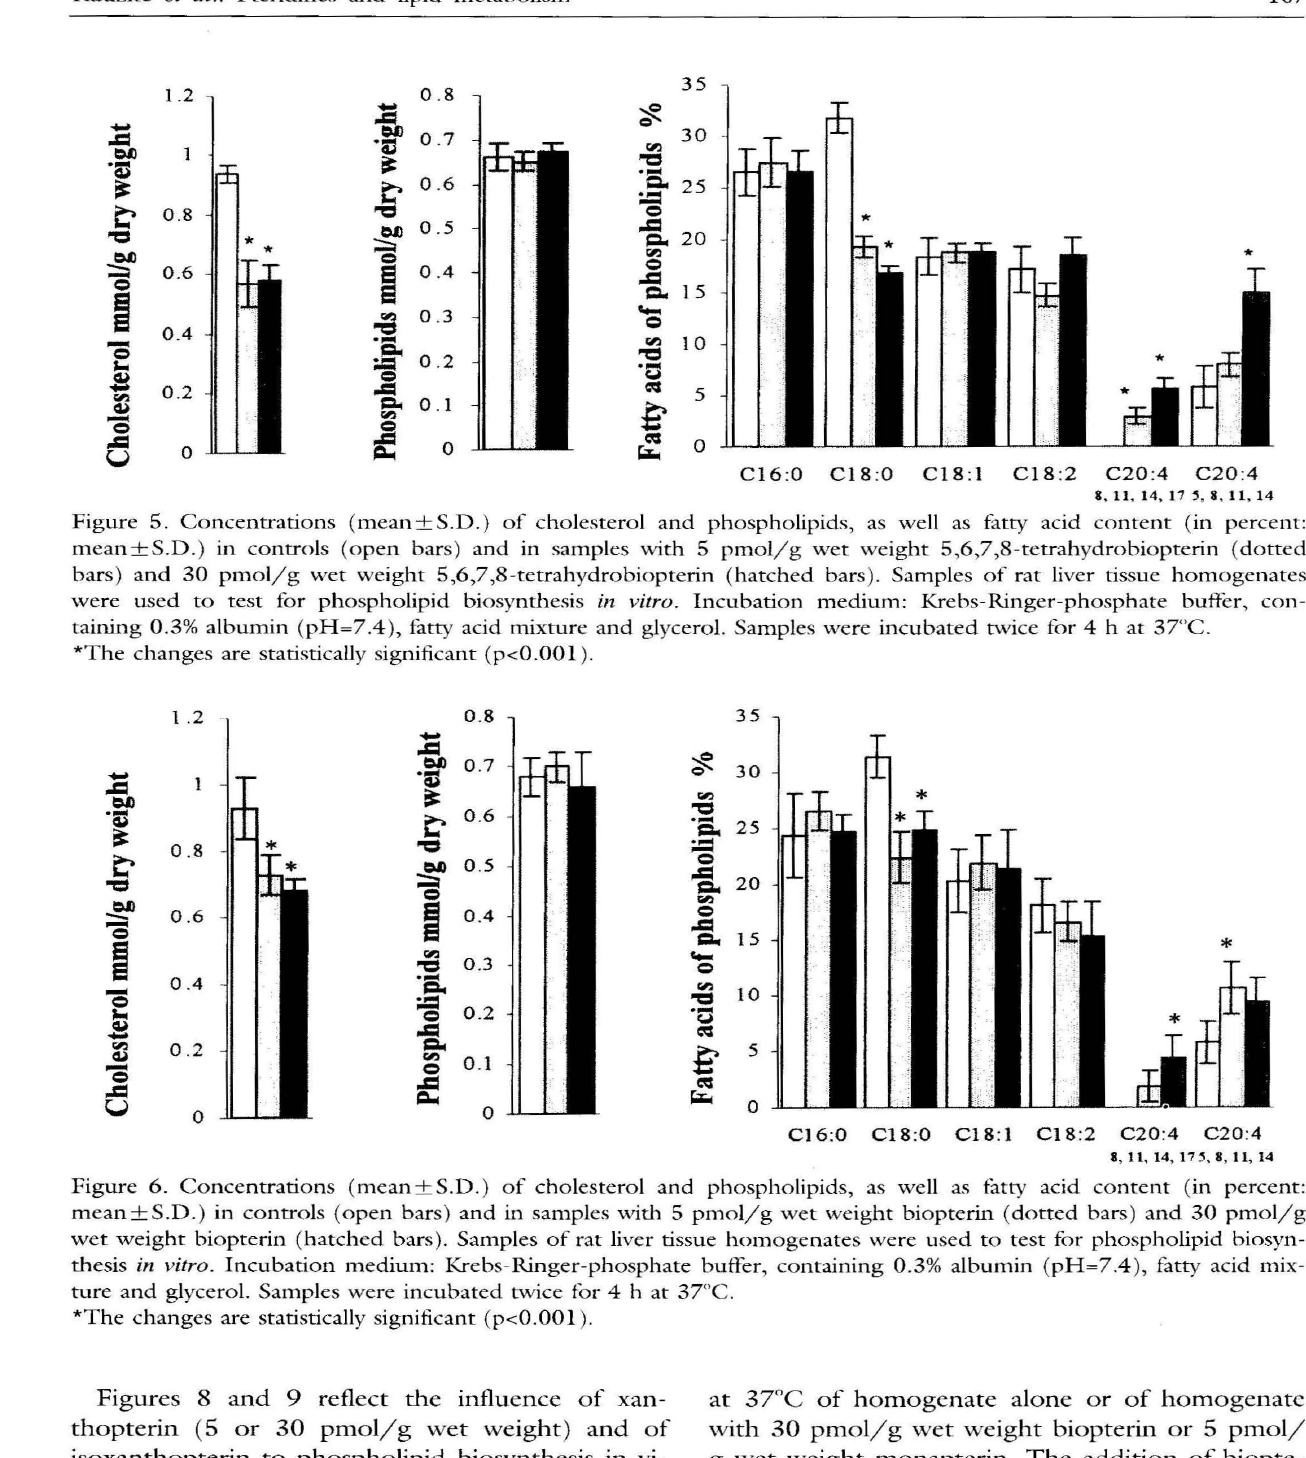
at 3rC of homogenate alone or of homogenate with 30 pmoljg wet weight biopterin or 5 pmolj g wet weight monapterin. The addition of biopte rin and monapterin to rat liver homogenate is fol lowed by an elevation of fluorescence in samples, which is typical for aromatic non-reduced pter idine derivatives. The incubation of rat liver homo genates containing bioptcrin or monapterin for 8 hours at 37°C is accompanied with a statistically significant decrease of fluorescence (p<O.OOl ). The Pteridines/ Vol. 9 / No.